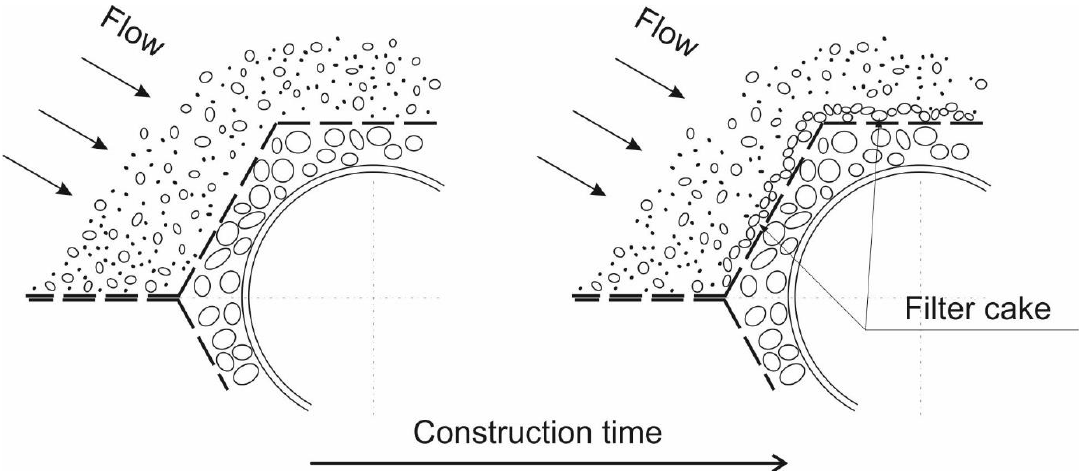
Figure 14. Formation of filter cake (bridge network) upstream of drainage nonwoven geotextile.